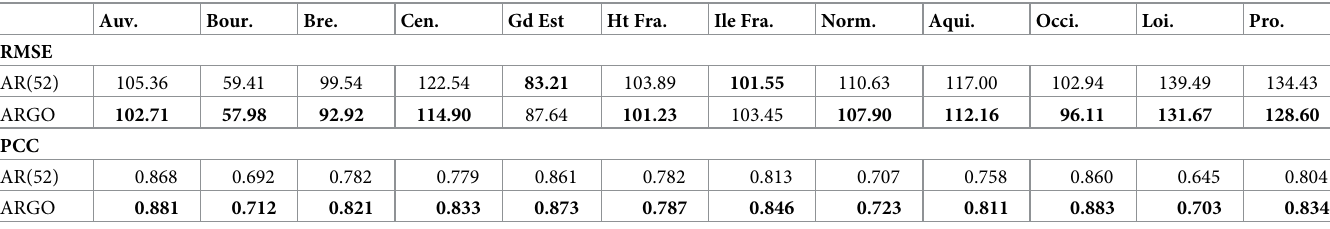
Table 8. One-week ahead estimate—RMSE and PCC for ARGO models including only historical data (AR(52)) and only Twitter data, for the period starting from January 2015 to March 2017. Auv. Bour. Bre. Cen. Gd Est Ht Fra. Ile Fra. Norm. Aqui. Occi. Loi. Pro. RMSE